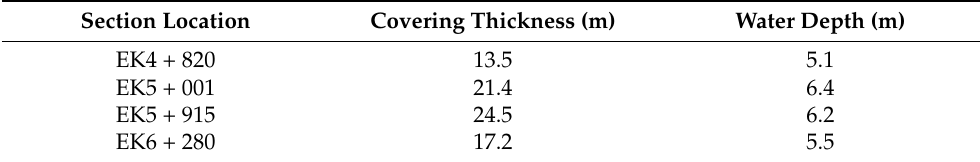
Table 3. Basic parameters of selected typical section.